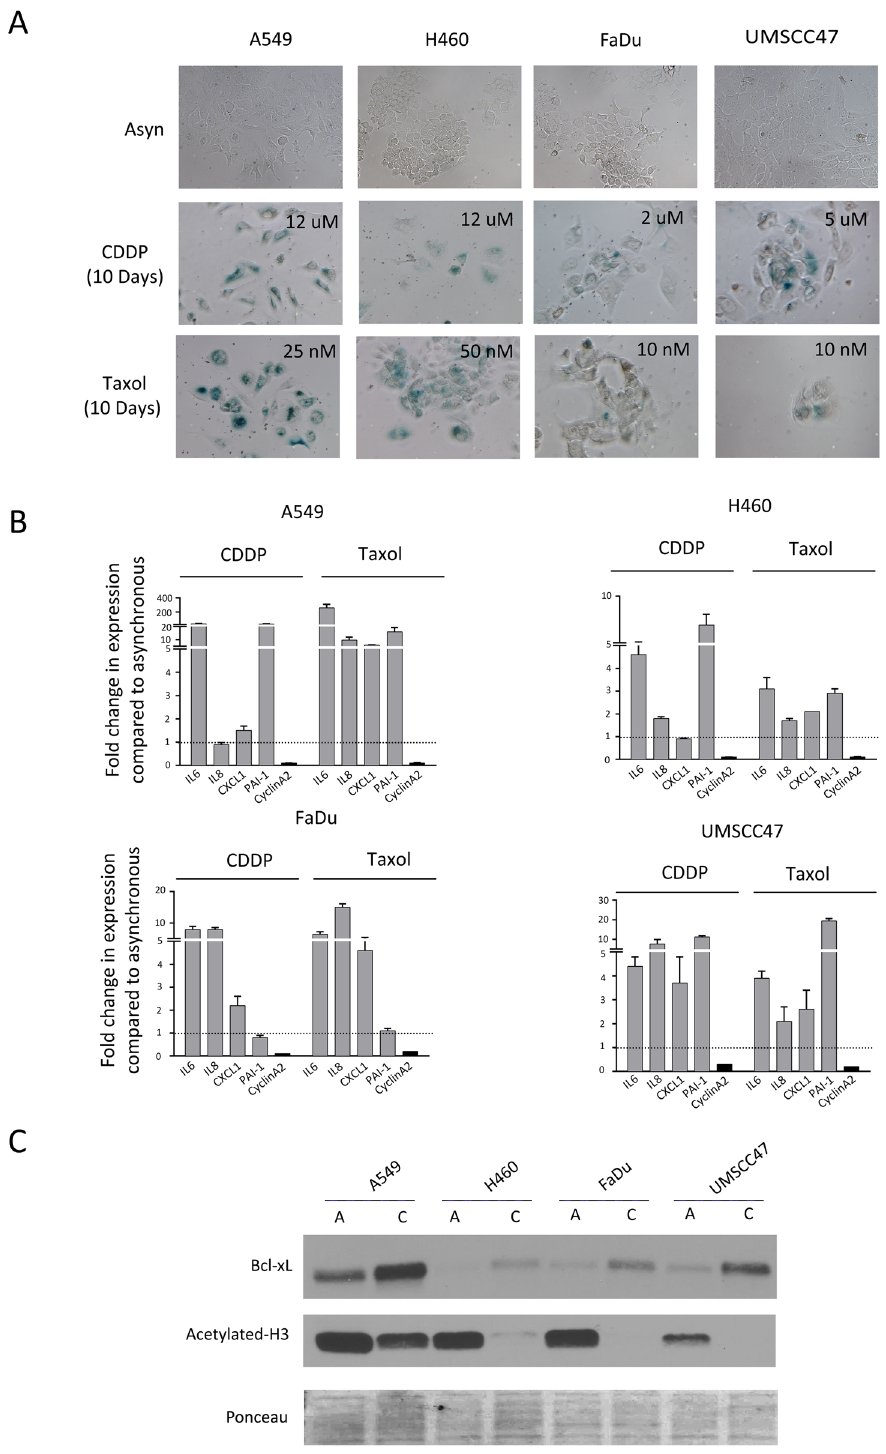
Figure 3. Senescence is a Common Outcome of Chemotherapy in NSCLC and HNSCC and is Associated with Altered Histone Acetylation and Bcl-xL Expression. Chemotherapy-Induced Senescent (CIS) populations were obtained by treating NSCLC (A549, H460) and HNSCC (UMSCC47, FaDu) cells with either cisplatin (CDDP) or Taxol for 10 days. The doses indicated were chosen to induce maximal cell death and residual, surviving cells typically become senescent. ( A ) Representative phase images of SA- β -gal-stained CIS populations (Magnification 10X), ( B ) Transcriptome analysis (qRT-PCR) of SASP-related gene expression and proliferation in 10 day old CIS populations. The dotted line represents baseline expression in vehicle-only treated asynchronous cells. Bars represent mean ± SD ( n = 3) ( C ) Representative immunoblot showing decreased H3 acetylation and increased expression of Bcl-xL in CIS populations [C] compared to asynchronous [A] NSCLC and HNSCC cells. Cisplatin (CDDP) was used as the senescent inducer and doses are denoted in